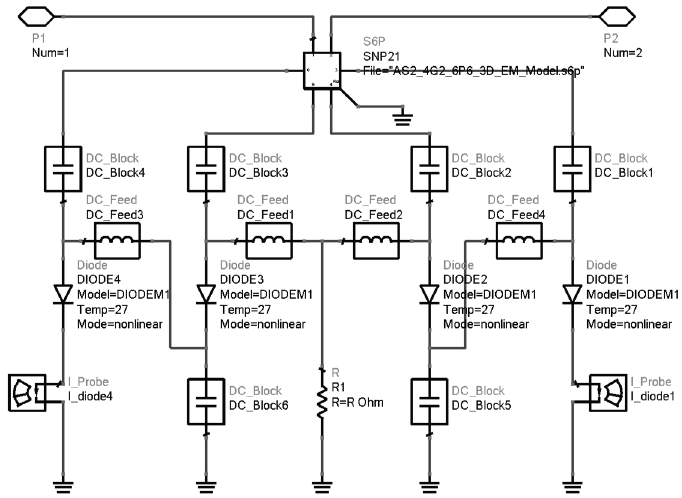
Figure 3. The equivalent circuit model of the diodes with self-bias resistor in ADS.